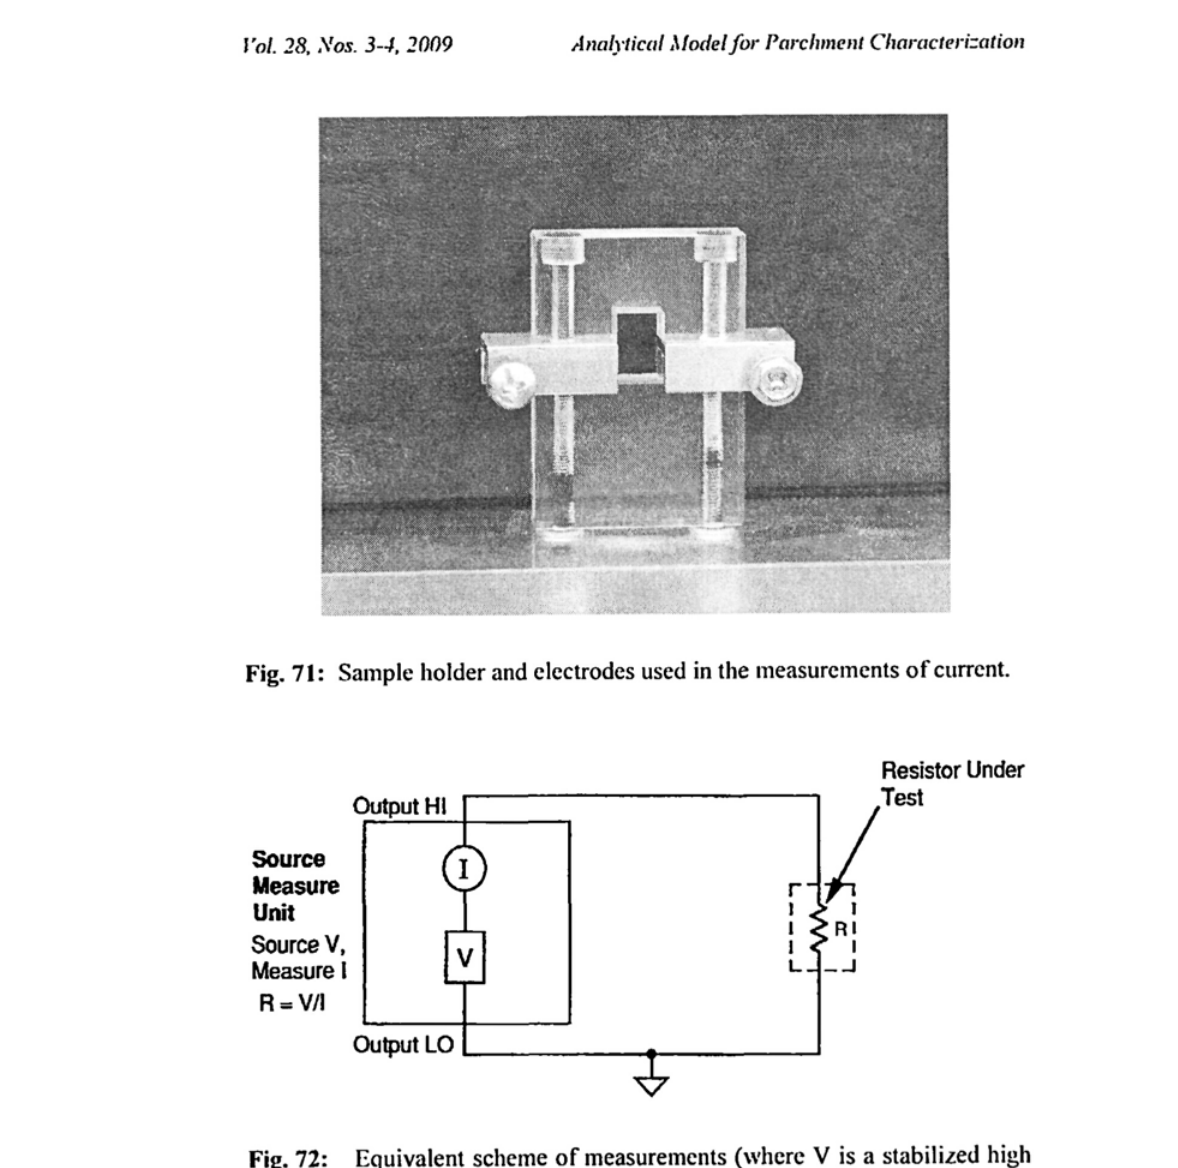
Fig. 72: Equivalent scheme of measurements (where V is a stabilized high voltage source and I is a current measurement